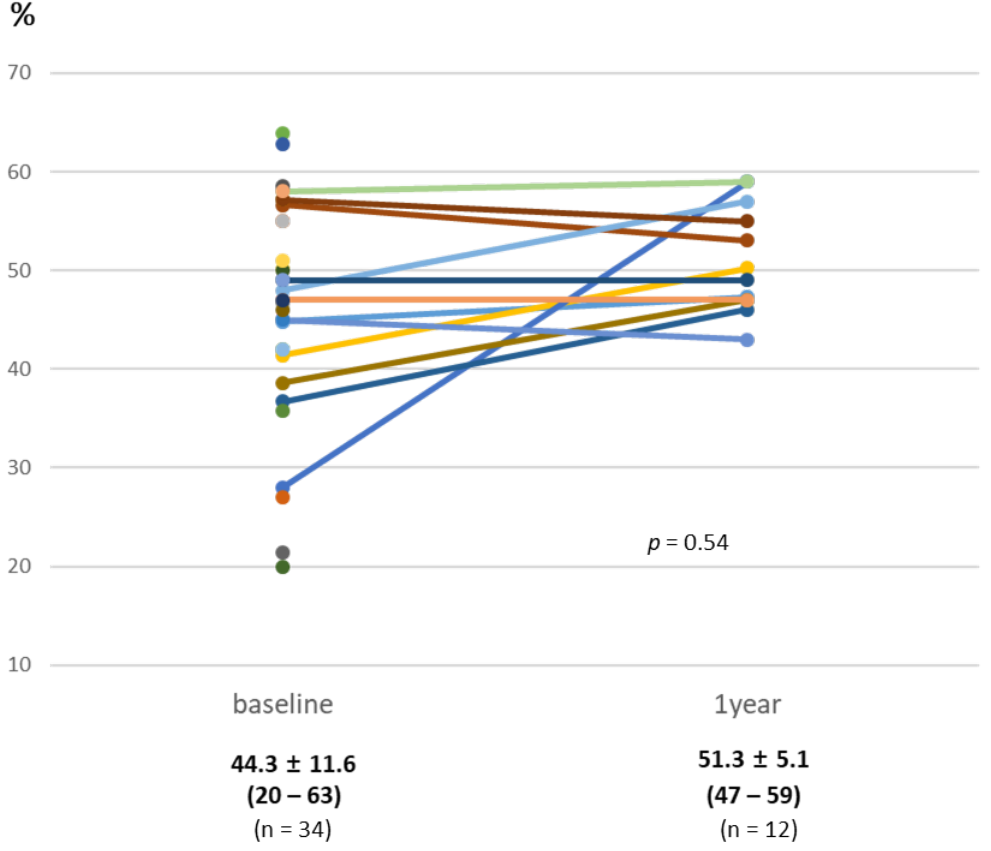
Figure 3. Changes in right ventricular volume before and 1 year after valve implantation. The mean indexed RV (right ventricle) end-diastolic volume index was significantly decreased after valve implantation, as seen on a cardiac MRI (magnetic resonance image).